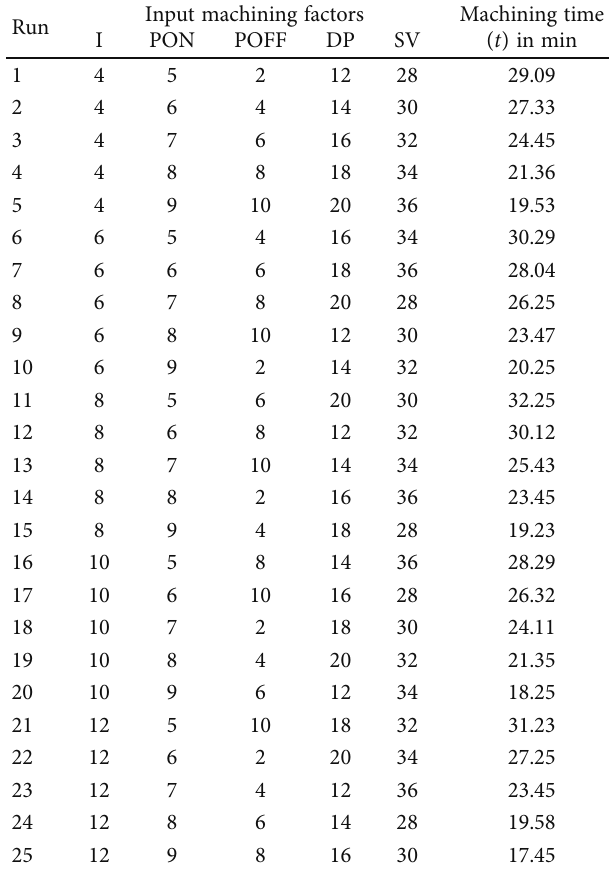
Table 2: Table design and time taken for machining.